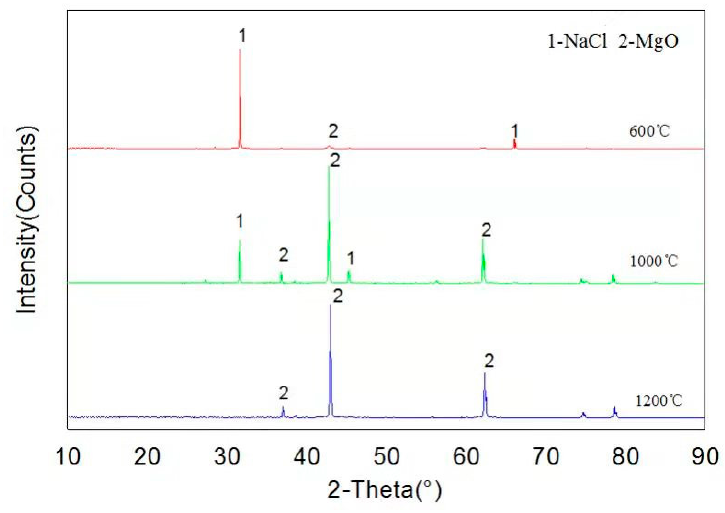
Figure 5. XRD pattern of the reaction products of NaCl and MgO.